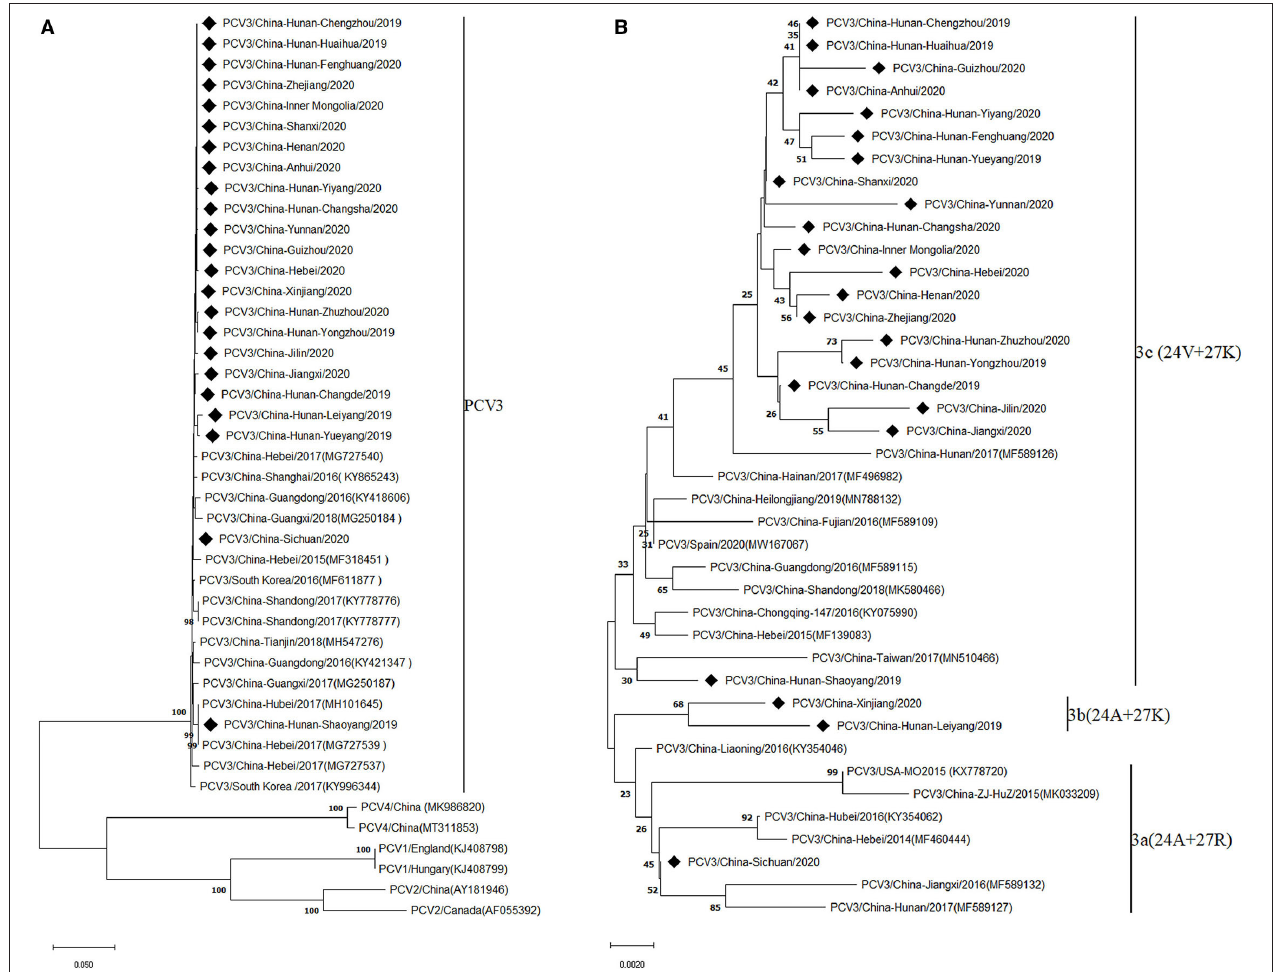
FIGURE 1 | Phylogenetic analysis of the complete genome (A) and capsid protein (B) of 23 PCV3 strains obtained in this study and reference strains from GenBank. Phylogenetic trees were constructed by the neighbor-joining method using MEGA 6.0 software. Black squares represent PCV3 strains identified in this